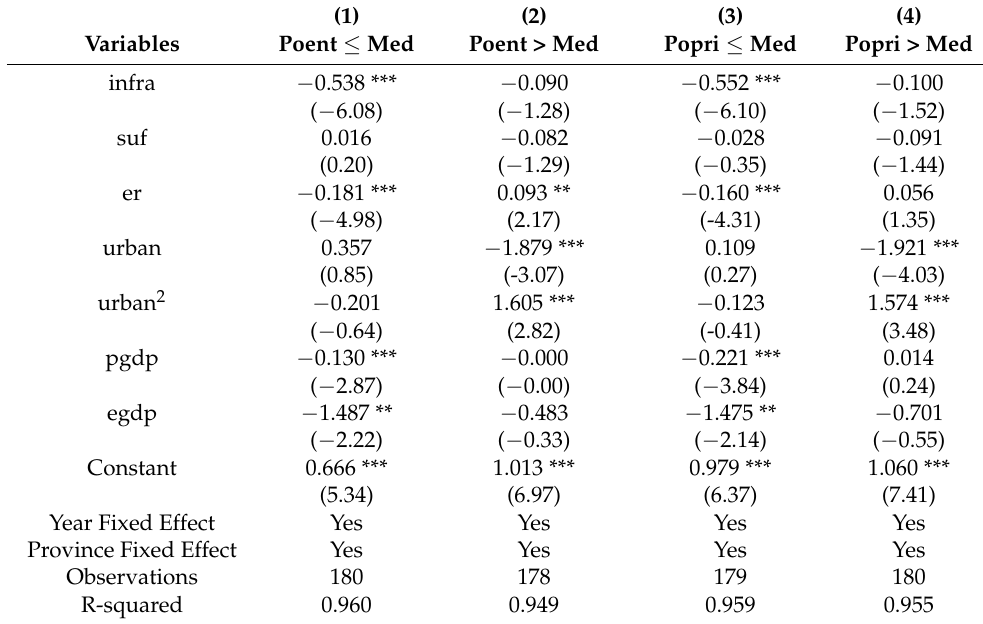
Table 7. The impact of NDI on energy transition in provinces with different pollution